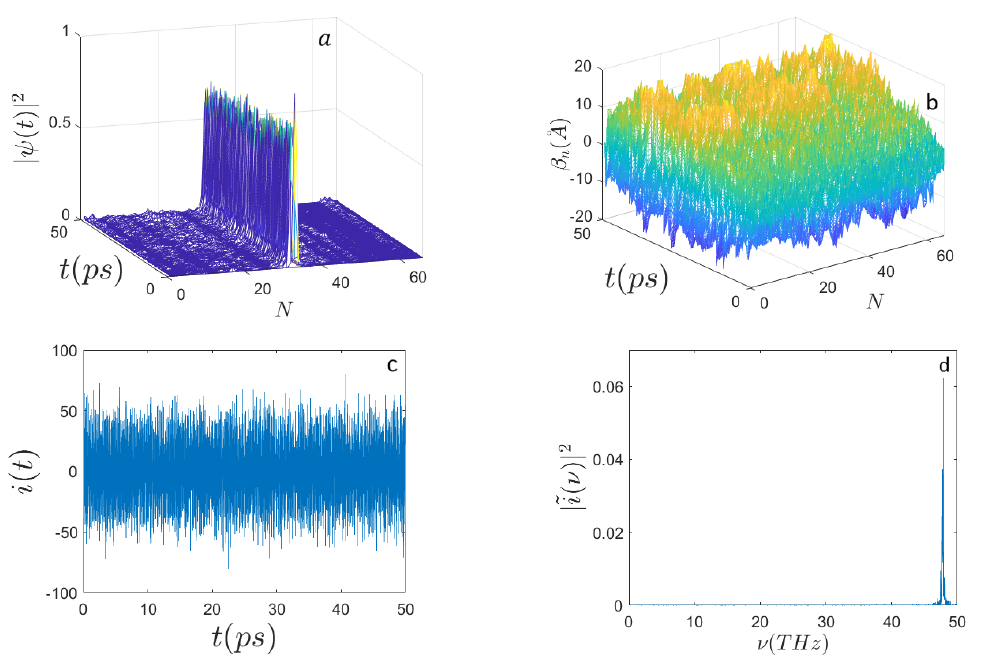
Figure 7. Time evolution of ( a ) the electron probability amplitude | Ψ ( t ) | 2 ; ( b ) the average displace- ments β n ( ˚ A ) ; ( c ) the electron current i ( t ) (expressed in µ biot); ( d ) the frequency spectrum | ˜ i ( ν ) | 2 along the sequence of N = 66 nucleotides with the initial conditions E 0 = 0.79 eV ( E (cid:48) = 120) and the initial electron excitation peaking around the site n 0 = N /2. The other parameters are the same as those in Figure 1.